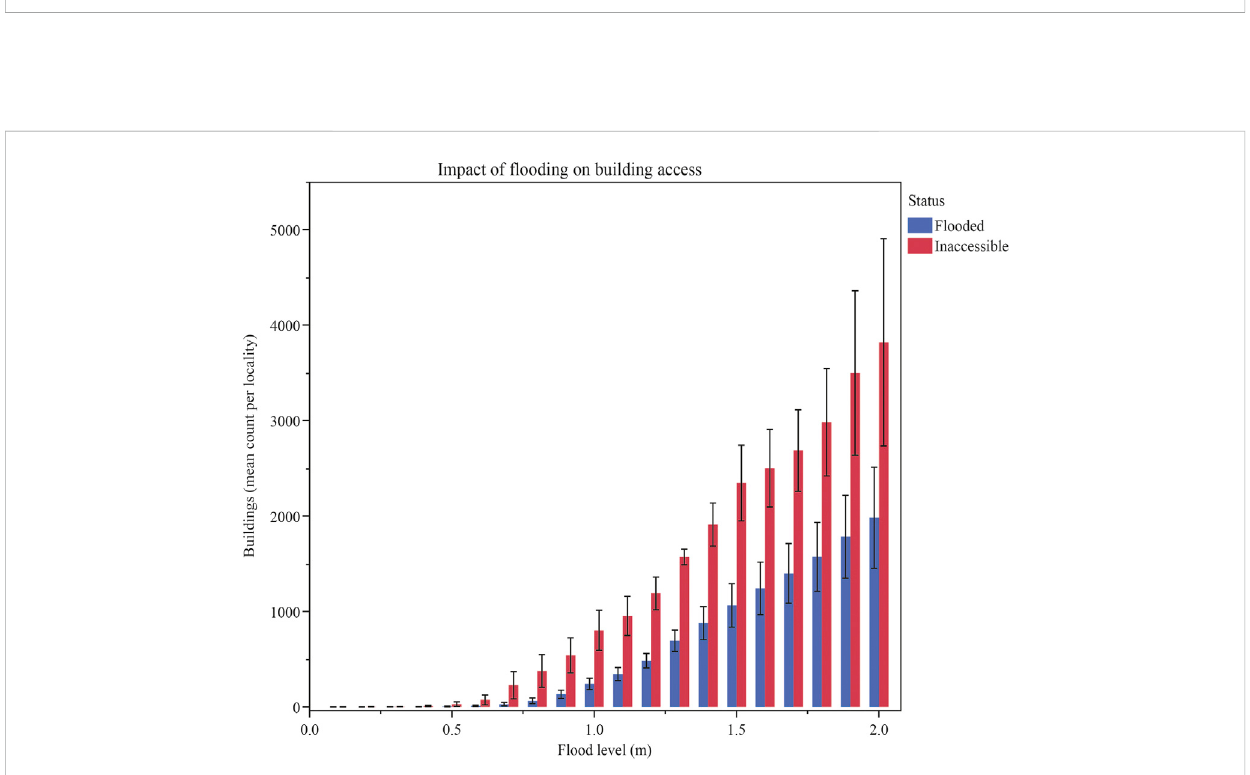
FIGURE 5 The impactofroad fl oodingon building access,pooledacross thethree testlocalities. Bars showtheaveragenumberofbuildingson fl ooded roads (in blue) and the average number of buildings in inaccessible areas (in red) for each fl ood level. Buildings on inaccessible roads were signi fi cantly higher when fl oodlevels werepooled(mean fl ooded=596.25,meaninaccessible=1,276.58,DF=1,FRatio =11.297, p -value=0.001)Errorbarsareone S.E.of the